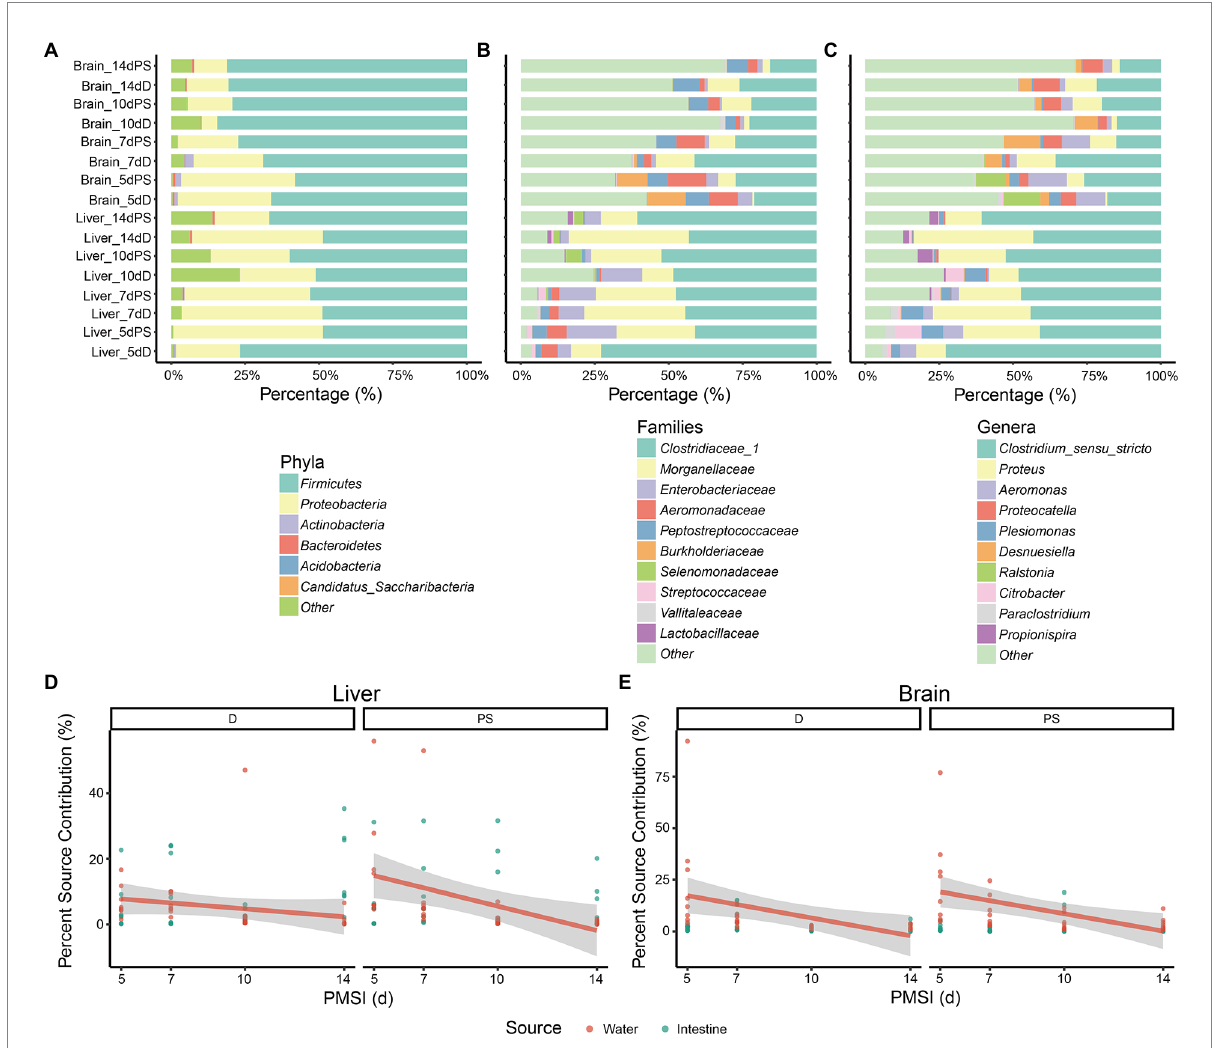
FIGURE 1 Composition of microbial communities in internal organs and microbial source tracking. (A–C) Relative abundance of bacterial taxa at different taxonomic levels. Stacked bar charts of the top 6 bacterial phyla (A) , top 10 bacterial families (B) , and top 10 bacterial genera (C) with the largest mean relative abundance in the liver and brain. Percentage source contributions of water-derived and intestine-derived bacteria to microbial communities in liver (D) , and brain (E) , over time were determined using FEAST. D, drowning group; PS, postmortem submersion